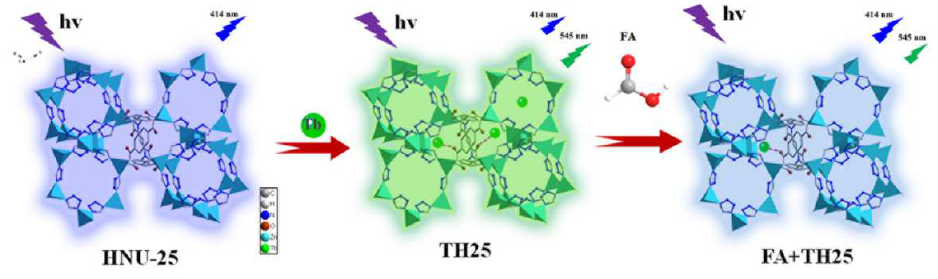
Figure 1. Schematic diagram showing the design and detection process of TH25 as fluorescence probe for FA. probe for